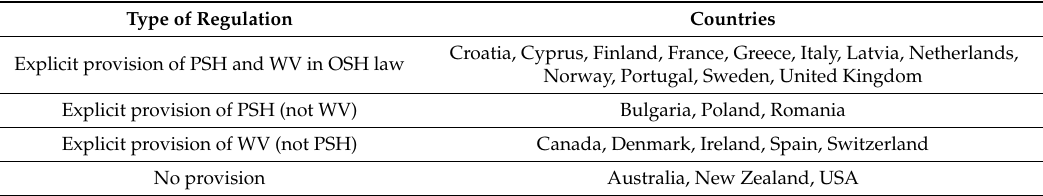
Table 2. Synthesis of di ff erences among developed countries in Psychosocial Hazards (PSH) and Workplace Violence (WV)